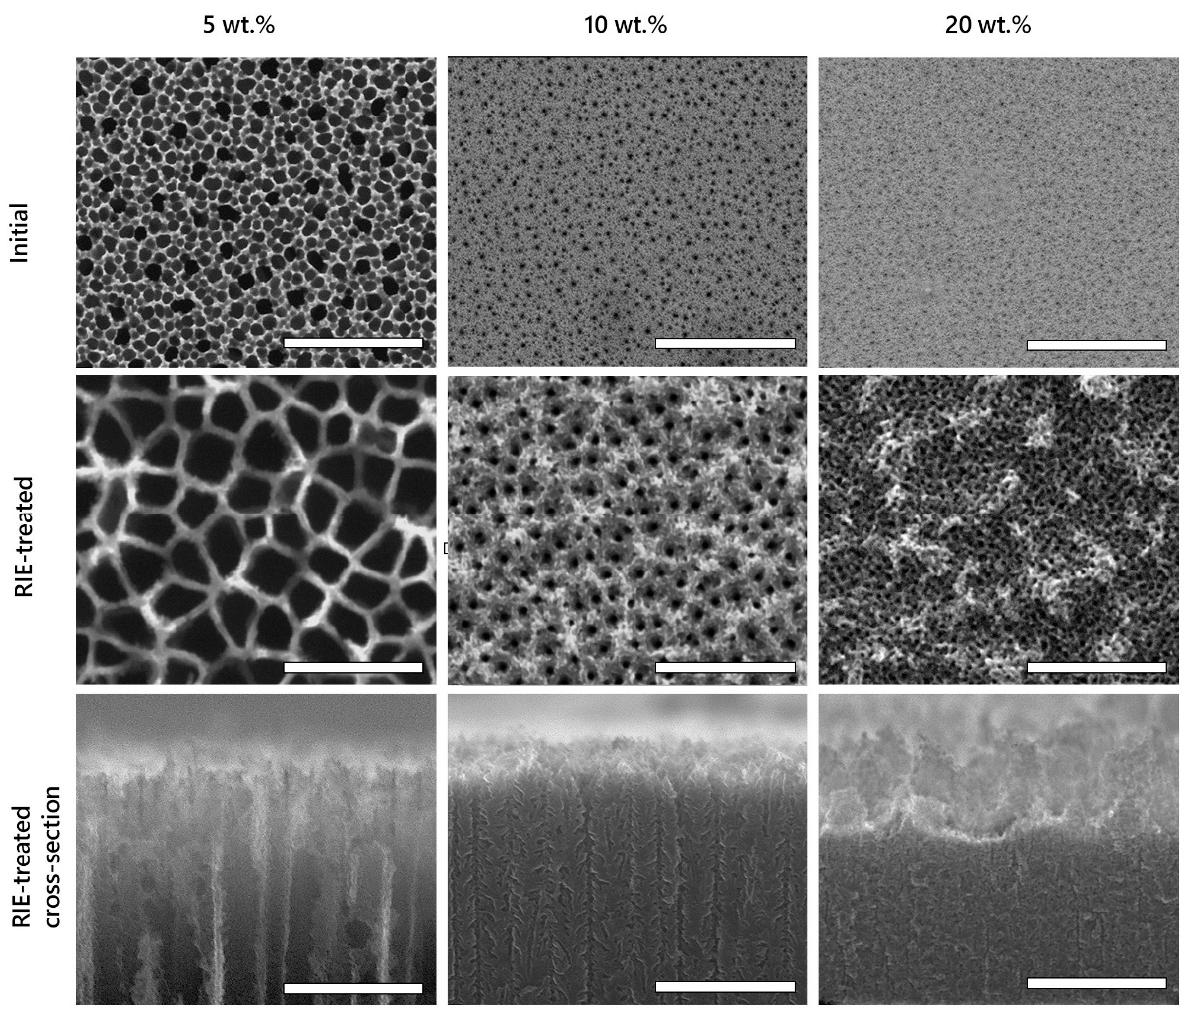
Figure 2. Top view of initial PS (on top) formed at j = 60 mA/cm 2 in the electrolyte with HF concentration 5 wt.%, 10 wt.%, 20 wt.%. Top view and cross-section of the same samples after RIE treatment (at the bottom). The scale bar is 500 nm.